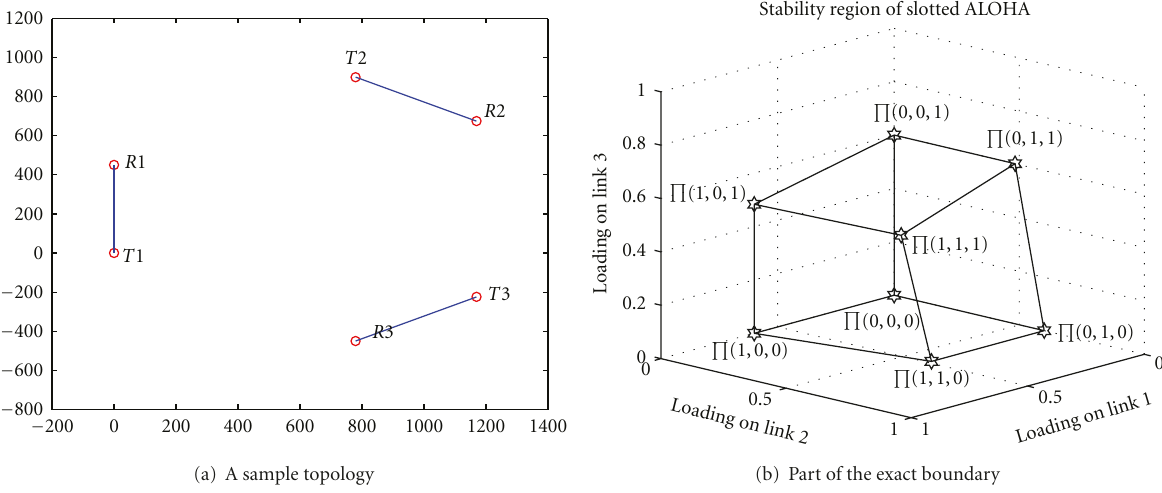
Figure 12: Stability region with M = 3.